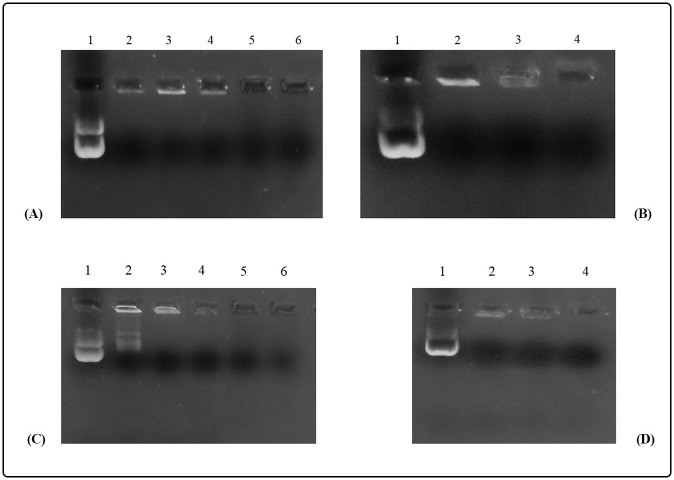
Analysis of the CPPs/DNA complexes.(A) Gel retardation assay of the HR9/pEGFP-nef-vif-gp160-p24 nanoparticles, Lane 1: pEGFP-nef-vif-gp160-p24 as a control in the absence of HR9, Lanes 2–6: The HR9/pEGFP-nef-vif-gp160-p24 complexes at different N/P ratios of 0.5, 1, 2, 5, 10, respectively; (B) Gel retardation assay of the MPG/pEGFP-nef-vif-gp160-p24 nanoparticles, Lane 1: pEGFP-nef-vpu-gp160-p24 as a control in the absence of MPG, Lanes 2–4: The MPG/pEGFP-nef-vif-gp160-p24 complexes at different N/P ratios of 2, 5, 10, respectively; (C) Gel retardation assay of the HR9/pEGFP-nef-vpu-gp160-p24 nanoparticles, Lane 1: pEGFP-nef-vpu-gp160-p24 as a control in the absence of HR9, Lanes 2–6: The HR9/pEGFP-nef-vpu-gp160-p24 complexes at different N/P ratios of 0.5, 1, 2, 5, 10, respectively; (D) Gel retardation assay of the MPG/pEGFP-nef-vpu-gp160-p24 nanoparticles, Lane 1: pEGFP-nef-vpu-gp160-p24 as a control in the absence of MPG, Lanes 2–4: The MPG/pEGFP-nef-vpu-gp160-p24 complexes at different molar ratios of 2, 5, 10, respectively.